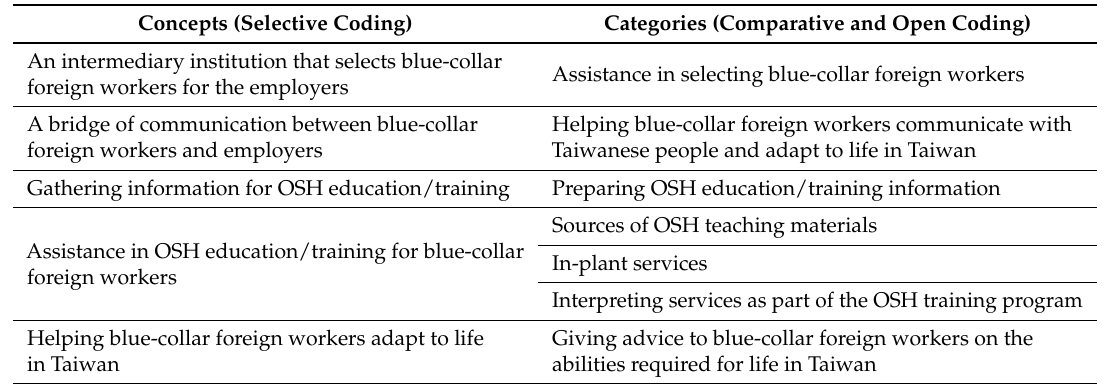
Table 3. Comparative and open coding as compared to selective